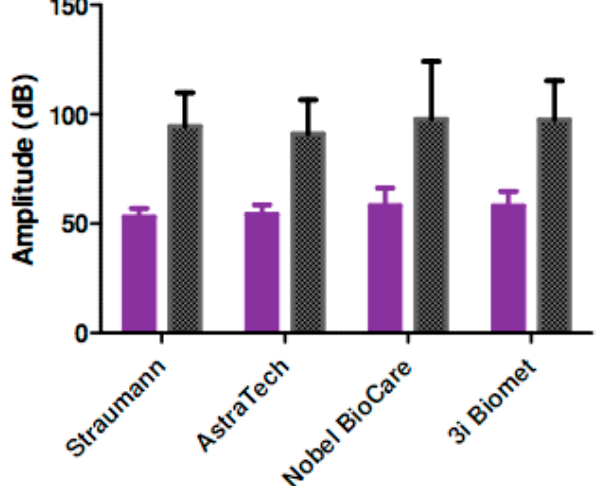
Figure 5. Graph correlation of initial and final fracture force (N). When the patterns of failure were explored, both internally- and externally-connected abutments fractured at the cervical aspect of the abutment adjacent to the abutment screw. In addition, abutment screws in the external connection groups experienced loosening, and in some samples, deformations were evident. There was no observable screw loosening in the internally connected assemblies. 4. Discussion This study evaluated the efficacy of AE analysis in the assessment of initial and final fracture forces of zirconia abutments. Implant systems with differing connections were chosen to assess for any difference in behaviour (Table 1). The relative strength of internal and external connections to the underlying implants was also analysed (Table 2). The methodology was not adapted to the ISO 14801: 2007 norm of in vitro tests on implants. It was to investigate only the implant/abutment